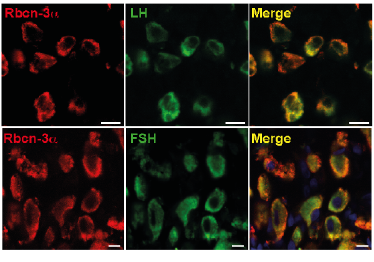
Figure 1. Rbcn-3 a is a synaptic protein that is also expressed in luteinizing hormone (LH) and follicle-stimulating hormone (FSH) expressing cells in adult rat pituitary glands and needed for the central control of